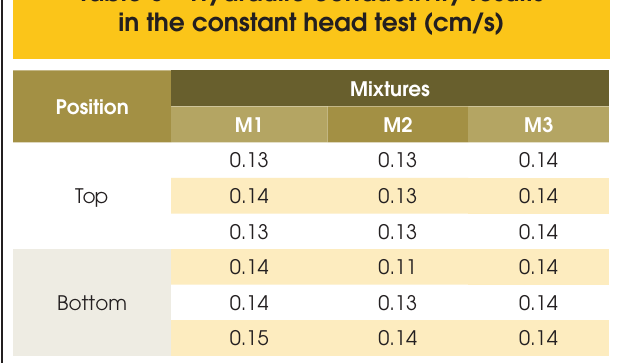
Table 5 – Hydraulic conductivity results Table 6 – Basic statistical analysis of hydraulic